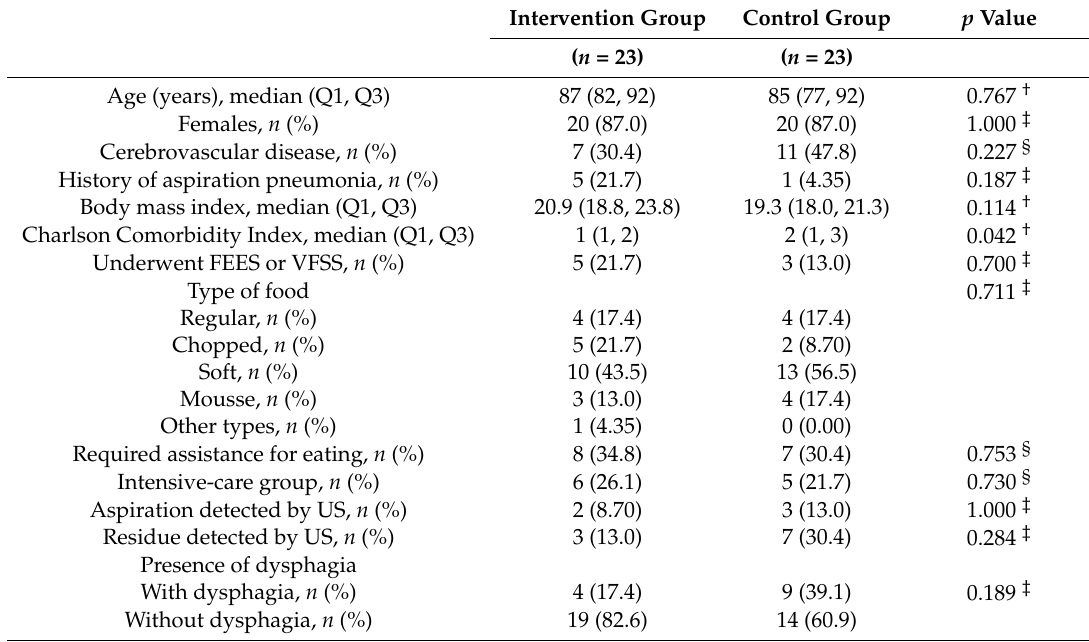
Table 1. Baseline characteristics of the participants.